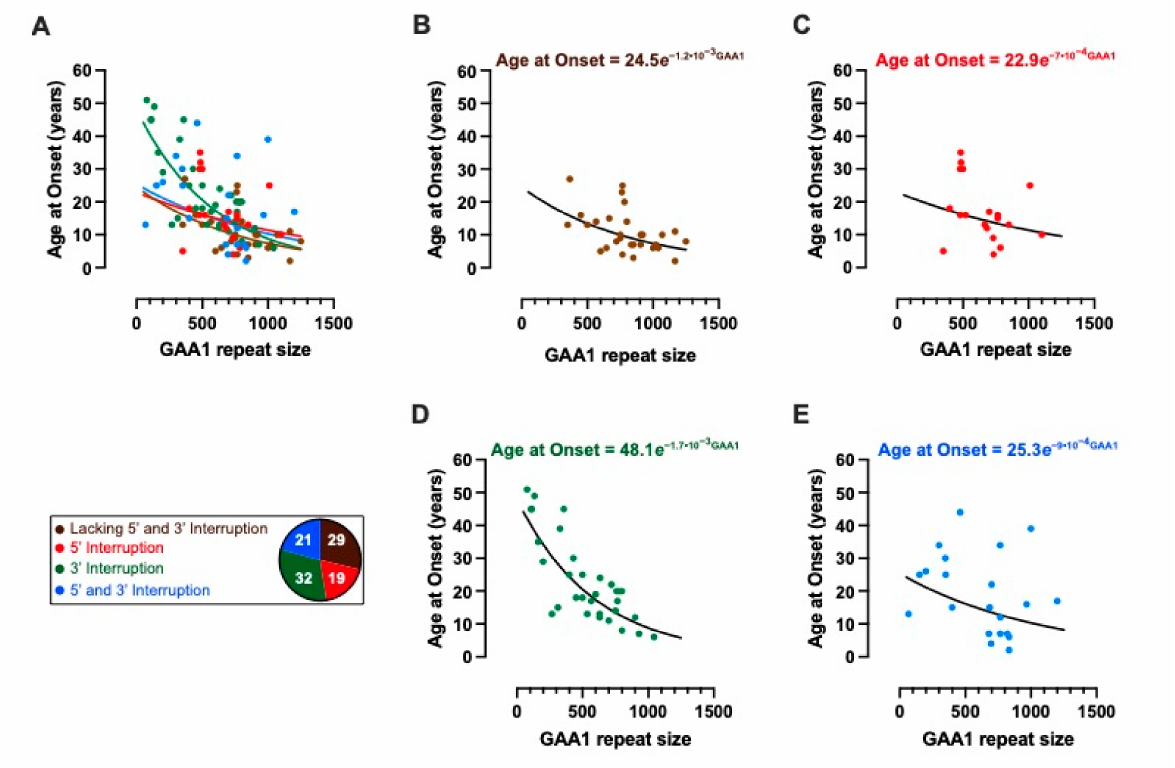
Figure 3. Ages at disease onset with respect to the smaller FXN GAA (GAA1) repeat size. The age at disease onset monotonically decreased with increasing GAA1 repeat size. This observed relationship was modelled as an exponential decrease, on a groupwise basis (adjusted R 2 = 0.342; F-statistic = 8.43, p = 5.96 × 10 − 8 ). ( A ) Actual and modelled dependence of the age at disease onset on GAA1 repeat size for the whole FRDA cohort ( n = 101). The subgroup membership is colour-coded according to the legend, which also indicates the number of patients per subgroup. ( B – E ) show the data, model results and model equation for each subgroup